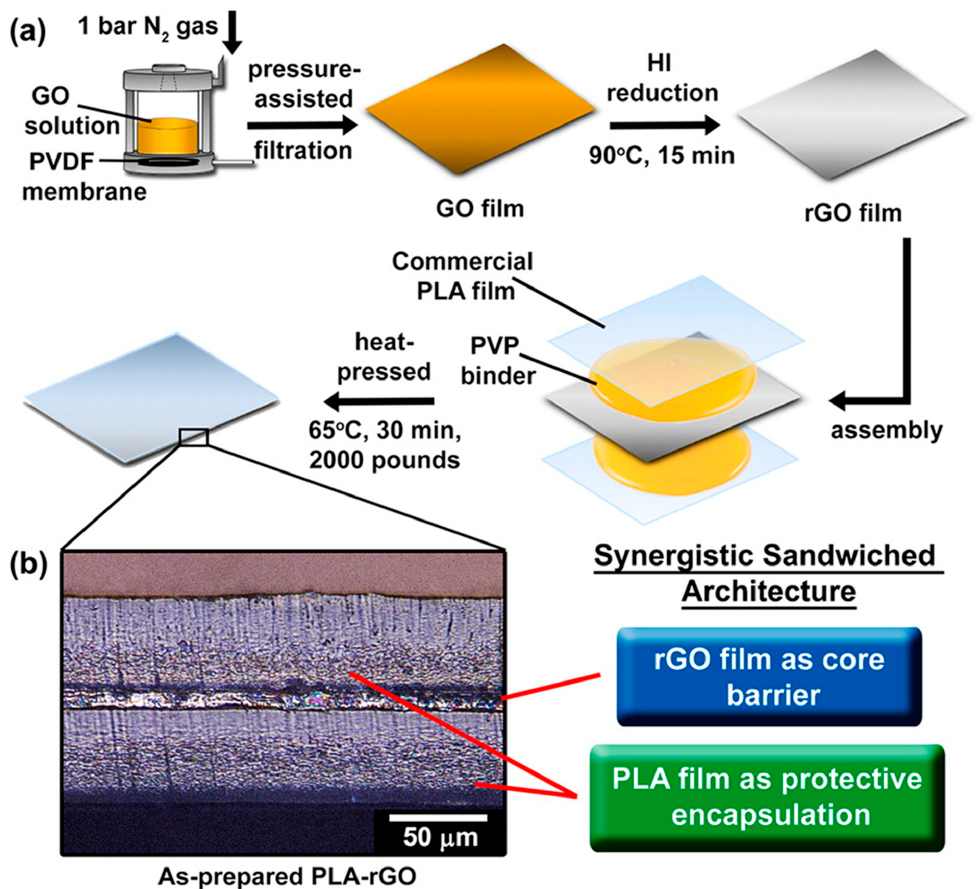
Figure 4. ( a ) Manufacturing scheme of PLA/graphene oxide (GO) film; ( b ) SEM micrograph showing the sandwich-like architecture of PLA/rGO films (reproduced with permission from [16]. Copyright the sandwich-like architecture of PLA / rGO films (reproduced with permission from [16]. Copyright 2016 American Chemical Society). 2016 American Chemical